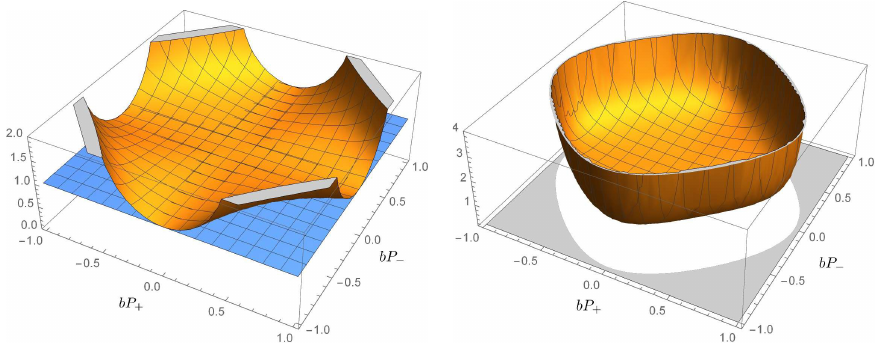
Figure 17. The 3D-profiles of the anisotropy velocity (173) with b α / b = 1 (left panel) and b α / b = 1.5 (right panel).